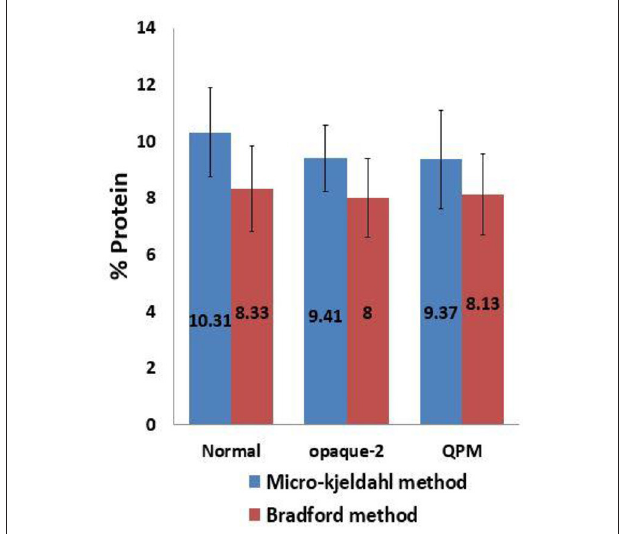
FIGURE 4 | Comparative evaluation of protein content estimated by micro-Kjeldahl and Bradford methods. Error bars denote overall ± SD of the genotypes at particular time